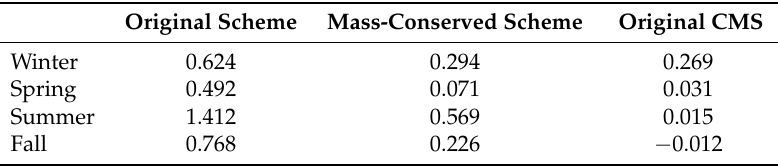
Figure 4. Seasonal model-model differences (WRF–CMS-Flux) in simulations of GOSAT XCO 2 . Table 3. Mean model residuals [ppm] relative to ACOSv3.5 GOSAT XCO 2 for WRF without and with mass-conserved coupling schemes and